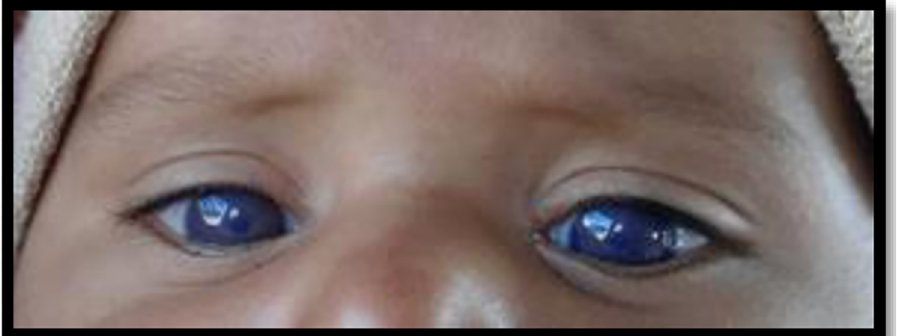
Fig 1. Affected individual of family PKCD-AI03 with CHED depicting bilateral hazy corneas.